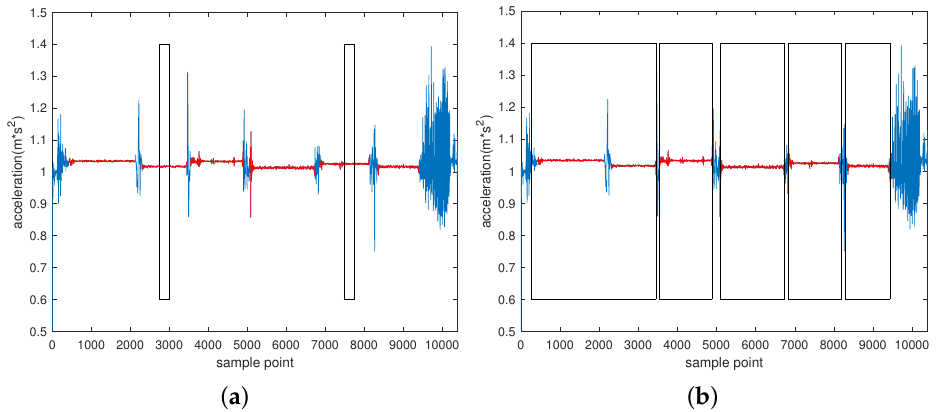
Figure 5. Segmentation results under different thresholds. ( a ) small threshold, and ( b ) big